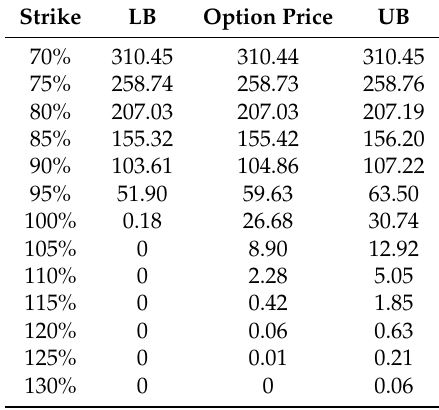
Table 1. European freight call option prices with a maturity of 1 month, for several strikes and their corresponding lower and upper